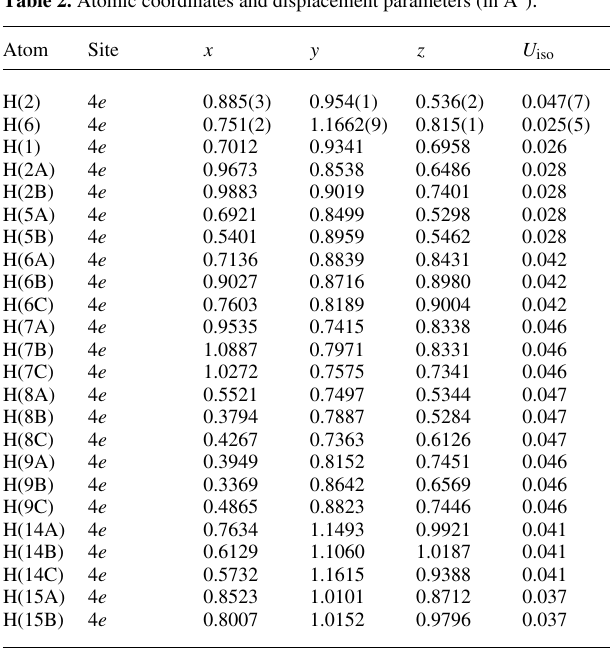
Table 2. Atomic coordinates and displacement parameters (in Å 2 )